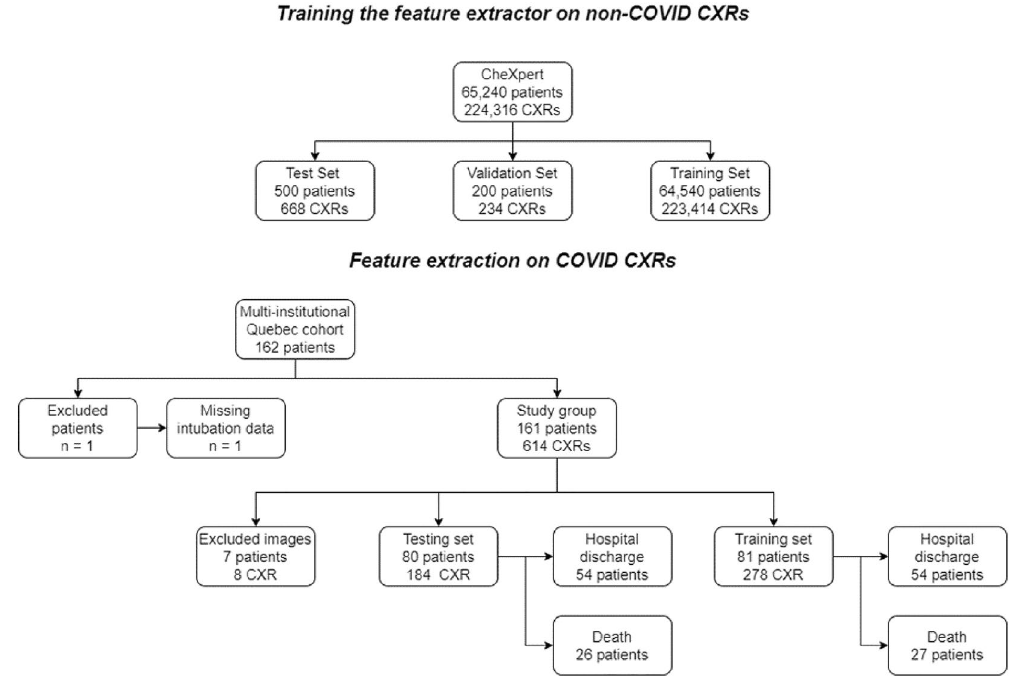
Figure 2. Study flowchart. The CheXpert training set is used to pre-train a general CXR feature extractor that is subsequently used on COVID patients. The CheXpert test set is not publicly available, and results were reported on the validation set.